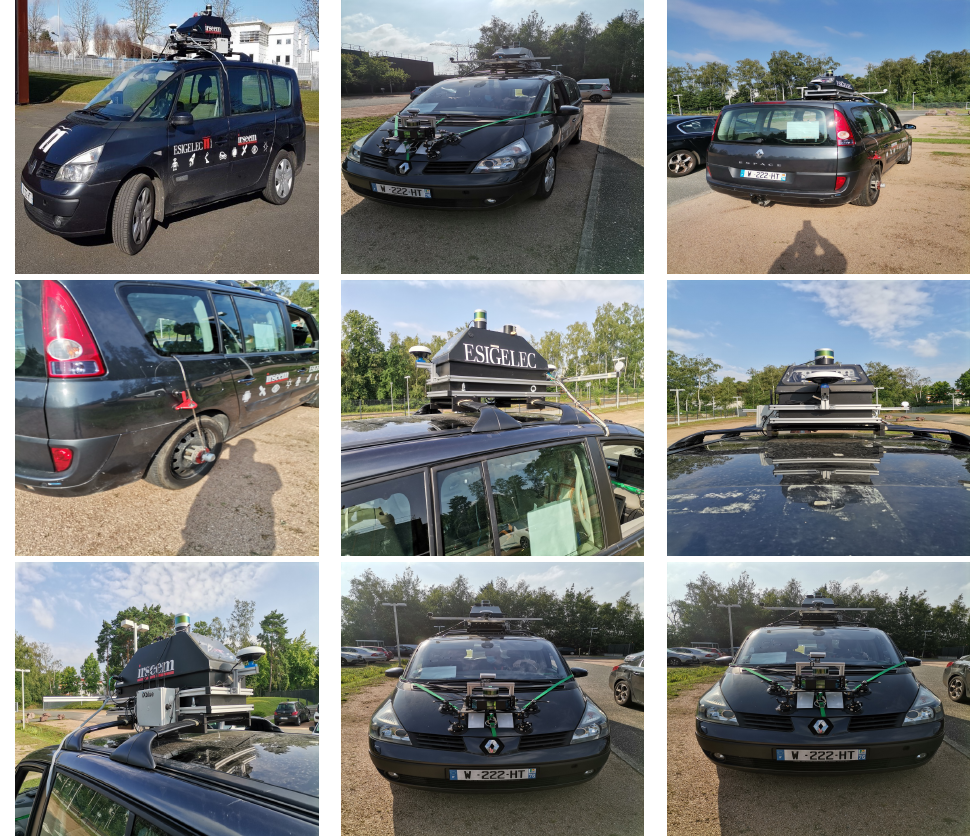
Figure 3. Instrumented IRSEEM Vehicle for data collection in smart mobility. The car trunk on the roof of the vehicle includes the whole sensors (Cameras, GPS/IMU, LiDAR, RADAR, Odometer). The odometer sensor is instrumented on the right rear wheel.